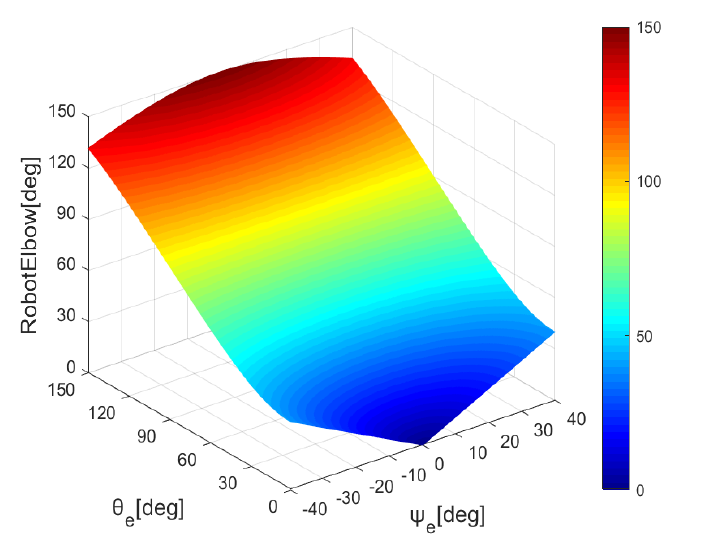
Figure 8. Elbow joint angle